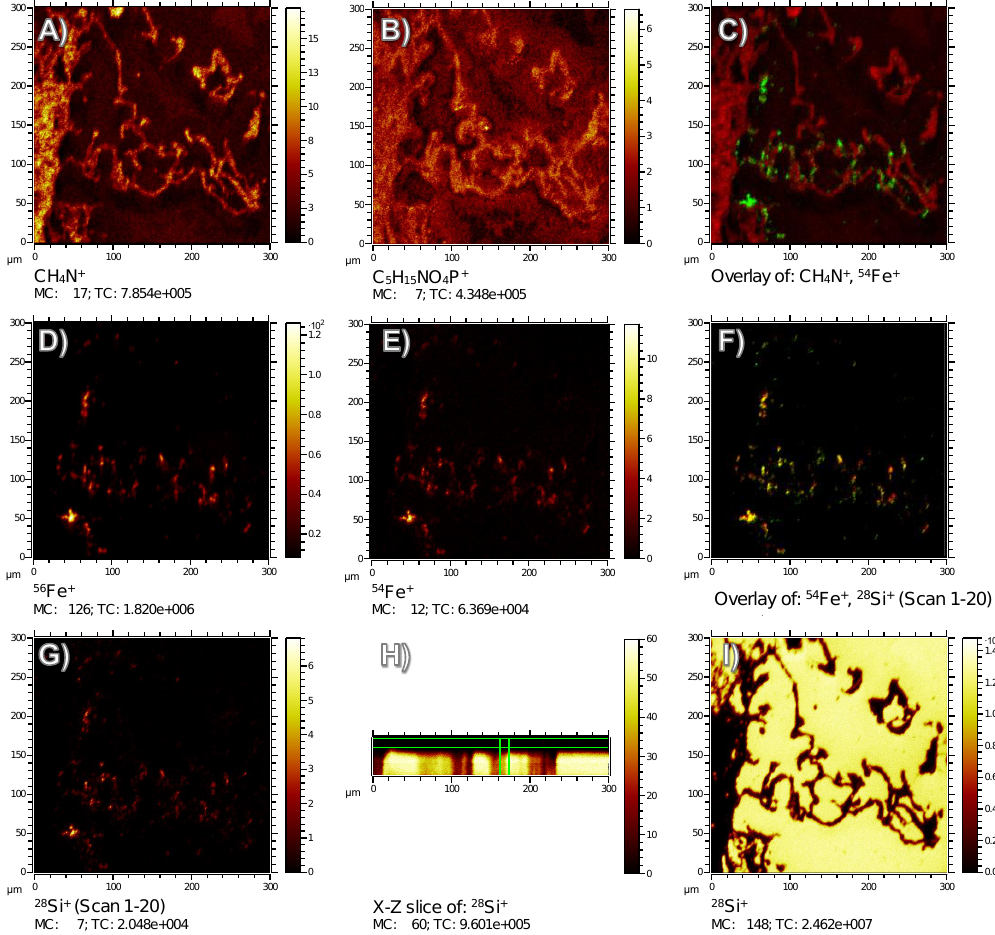
Figure 4. ToF-SIMS signal distributions of organic and inorganic components in a Fe/Si core/shell nanoparticle-containing lung tissue section 30 min post intratracheal instillation of particles. ( A ) CH 4 N + indicative of proteins to show tissue distribution and lung structure. ( B ) C 5 H 15 NPO 4+ is the phosphocholine (PC) head group fragment showing the distribution of lipids of lung tissue and surfactant; PC signal seen in the alveolar space is interpreted as to be artificially dislocated during filling of the lungs with cryomatrix. ( C ) Overlay of 54 Fe + (green) and CH 4 N + (red) signal showing Fe-Si-NP distribution in lung tissue. ( D ) 56 Fe + , and ( E ) 54 Fe + distributions of Fe-Si-NP particles. Small and large agglomerates appear alongside the alveolar walls. ( F ) The overlay of 54 Fe + ( D , red) and 28 Si + ( G , green) reveals the colocalization of both particle-related signals. ( G ) ToF-SIMS signal distribution of Si species from the topmost layers as indicated by the horizontal green lines in the X-Y slice of the ToF-SIMS dataset in ( H ). ( I ) 28 Si + signal distribution integrated for the complete depth including the indium tin oxide-coated glass slide.